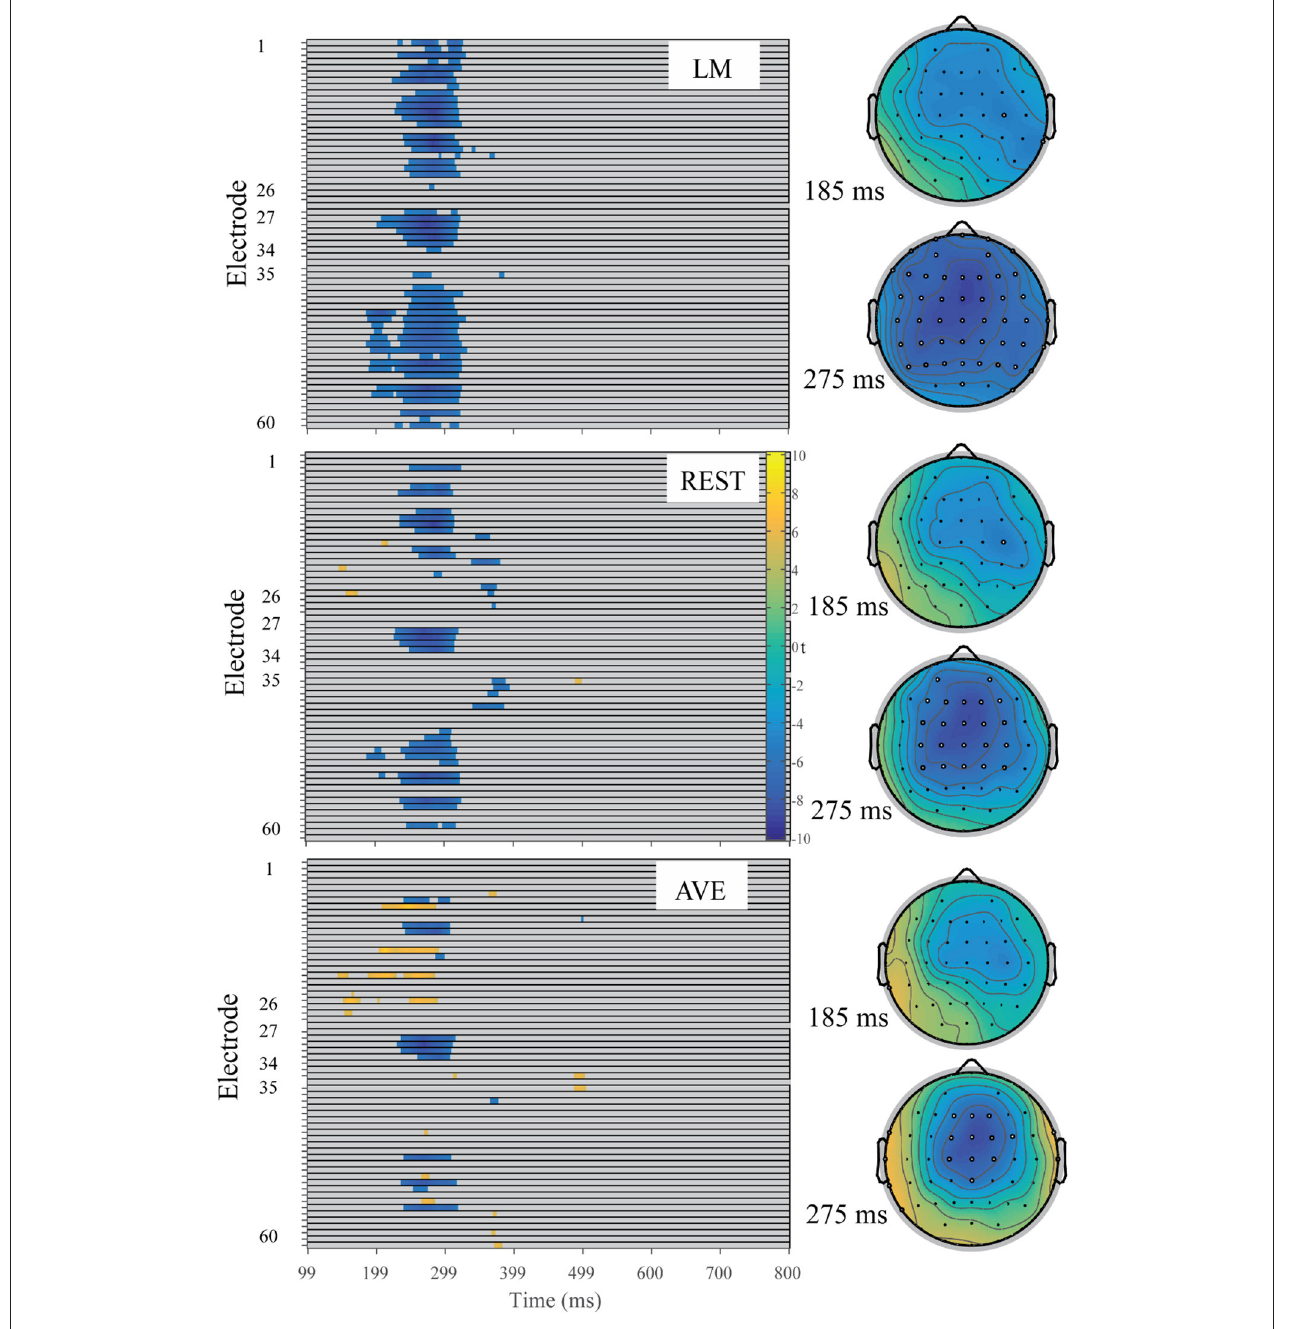
FIGURE 3 | Raster diagram illustrating the significant FRN effects according to t -test permutation tests using three reference approaches. Blue and yellow rectangles indicate the time points and electrode sites at which the ERP effects are significantly smaller and larger than zero, respectively. Gray rectangles indicate time points and electrode sites at which no significant differences were found. Right: the corresponding t -value topographical maps at 185 and 275ms for each reference approach. The white electrode indicates the significant FRN effect at that site while the black electrode indicates no significant at that